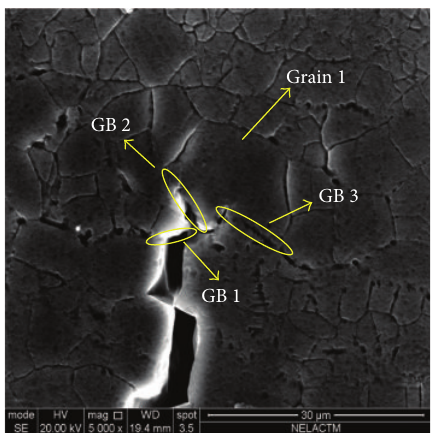
Figure 7: Micromorphology of fatigue crack at 111